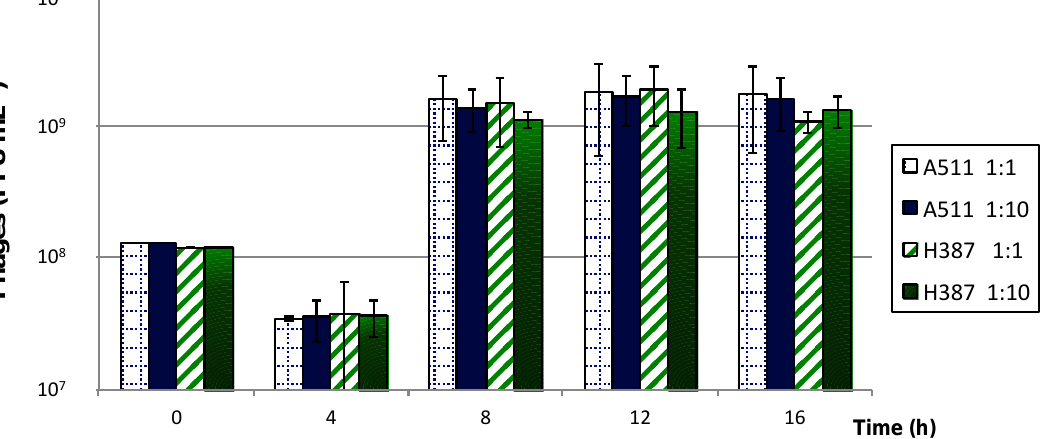
Figure 4. Production of phages A511 and H387 on Listeria ivanovii WSLC 3009 immobilised in alginate beads, using 1 and 0.1 multiplicities of infection (MOIs). Phage titers were measured every 4 h. Mean values were calculated from two independent experiments, and error bars correspond to standard deviations.